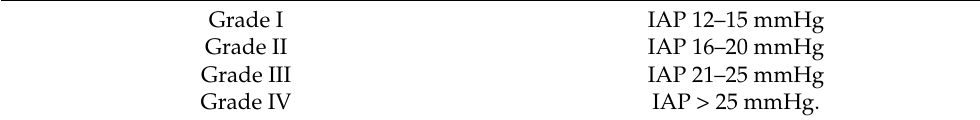
Table 1. The grading system of intra-abdominal